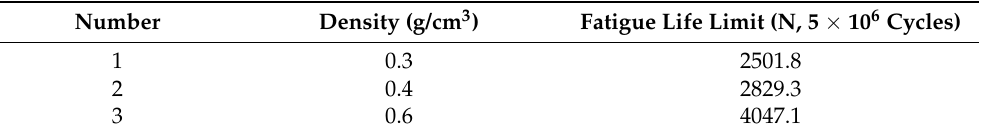
Table 4. Fatigue life limit of aluminum foam sandwiches with different core densities.